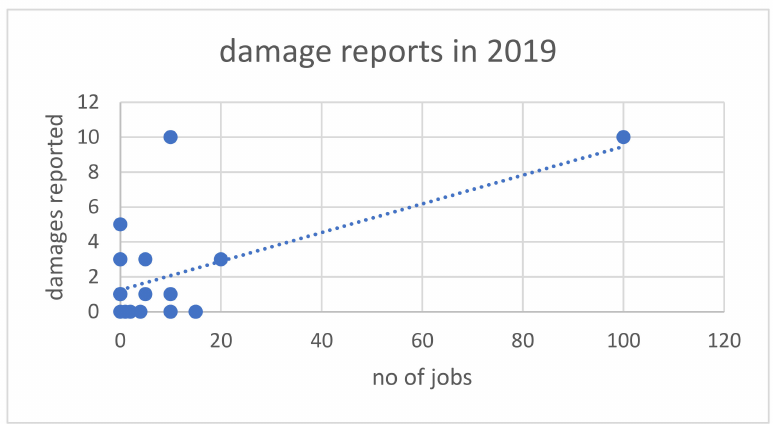
Figure 3. Scatter plot and linear relation graph between reported utility damages and carried out jobs by contractors in